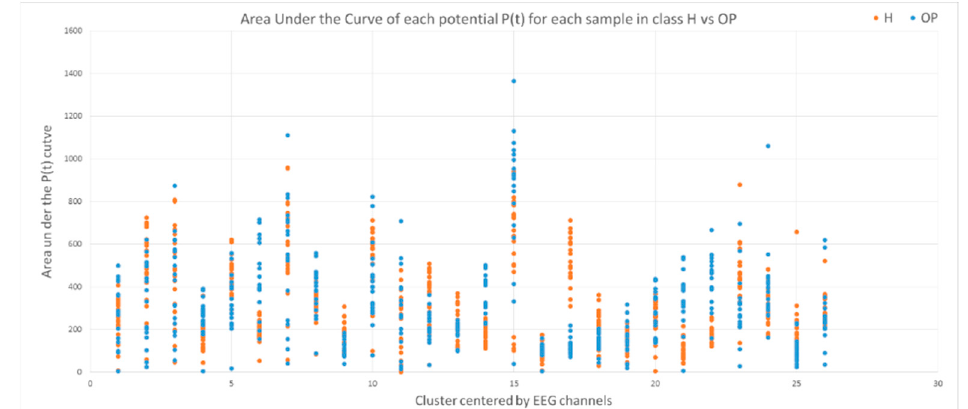
Figure 9. The local maximum of the potential P max ( t ) for four clusters (corresponding to Fp1, Fp2, F7, and F3 variables) that are plotted as dots in time t for all the EEG samples in two classes: control class (red) and OP class (blue). The P max ( t ) values can show the level of difference between the two classes (control and OP) in the EEG variables with p -value < 0.05 (measured by a t -test). The EEG variables with high p -value are not statistically significant.